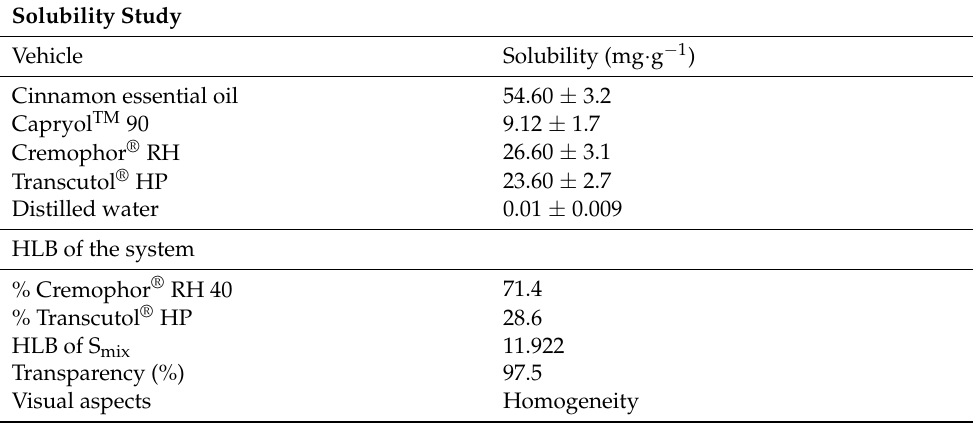
Table 4. Findings of preformulation